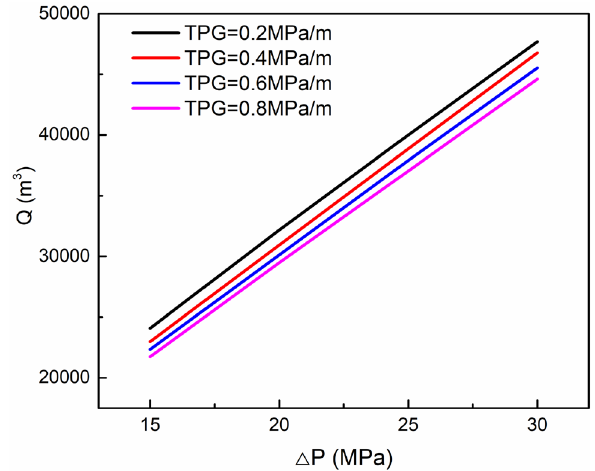
Fig. 7 Cumulative oil production versus pressure drop for different threshold pressure gradients